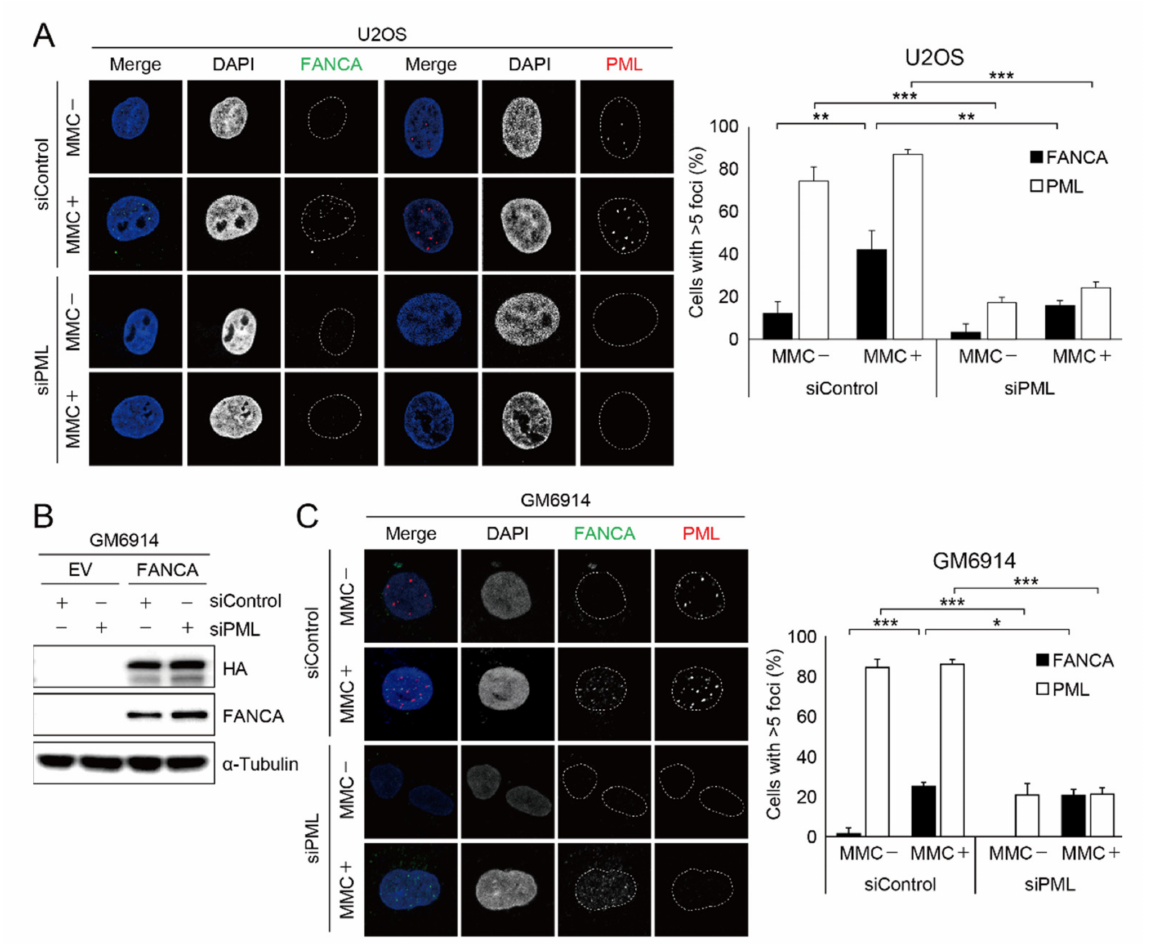
Figure 2. PML induces FANCA recruitment at the sites of DNA damage. ( A ) U2OS cells transfected with siControl or si PML were treated with 1 µ M MMC. The next day, cells were immunostained with the endogenous anti- FANCA antibody. Representative images and their quantification are shown. Over 40 nuclei were counted for statistics. Values are expressed as mean ± SD from three independent experiments (*** p < 0.001; ** p < 0.01). ( B ) Depletion of PML in GM6914 expressing empty vector or HA-tagged FANCA . HA and FANCA protein expression was determined by Western blot assay. ( C ) After PML depletion, GM6914/ FANCA cell lines were treated with 1 µ M MMC for 24 h and immunostained with the anti-HA and anti- PML antibodies. Representative immunofluorescence images and their quantification are shown. Over 40 nuclei were counted for statistics. Data represent the mean ± SD from three independent experiments (*** p < 0.001; * p <